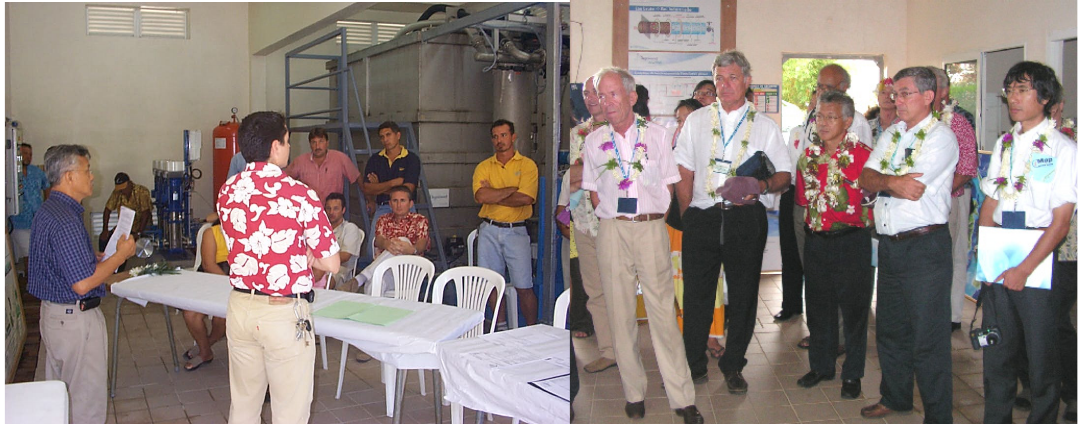
Figure 8. View of public forums organized at the water recycling